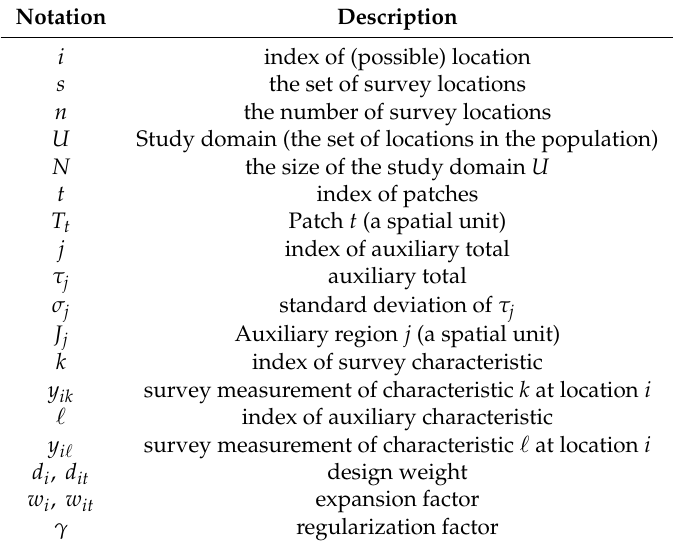
Table 1. Table of